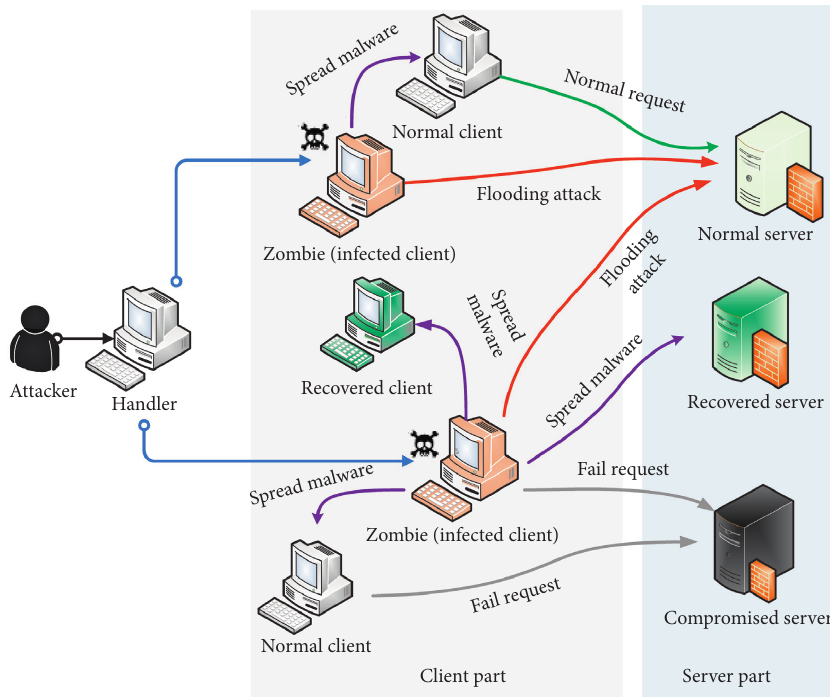
Figure 1: Schematic of a DDoS